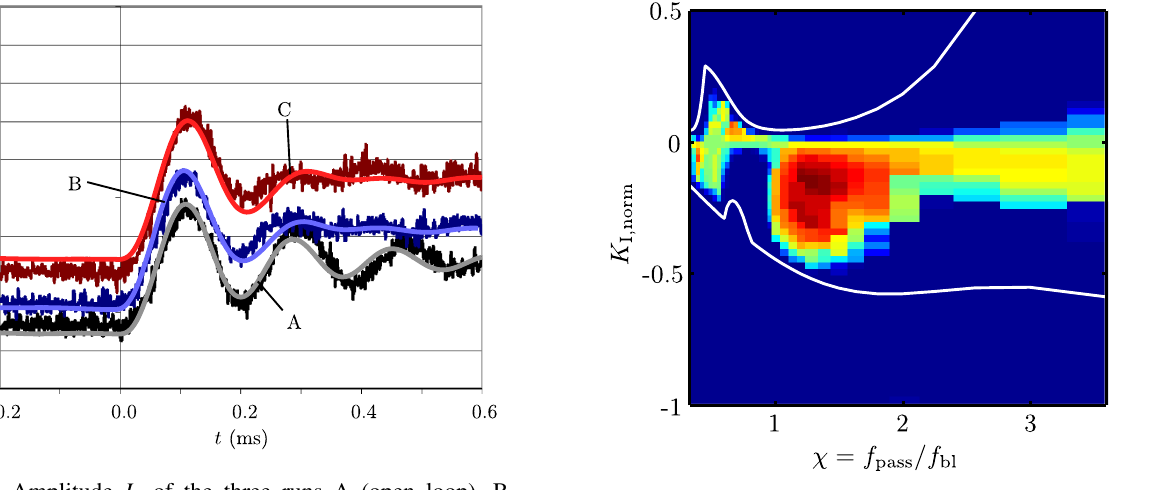
FIG. 12. Settling time for the nonlinear tracking simulations of scan 1 with stability margins for d ¼ 0 : 045 (white line).